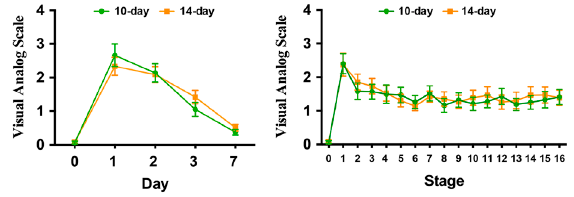
Figure 6. Pain perception (VAS score, mean ± standard error) of the 10- day and 14-day groups was similar throughout the